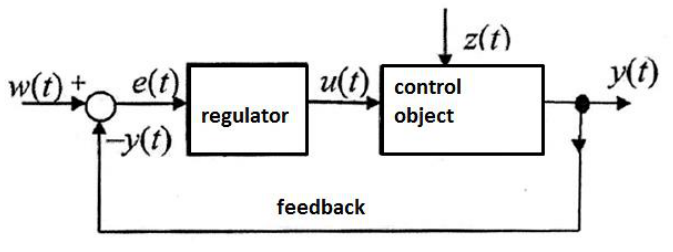
Figure 5. Dynamic adaptive model in terms of the system. Adaptation as a feedback